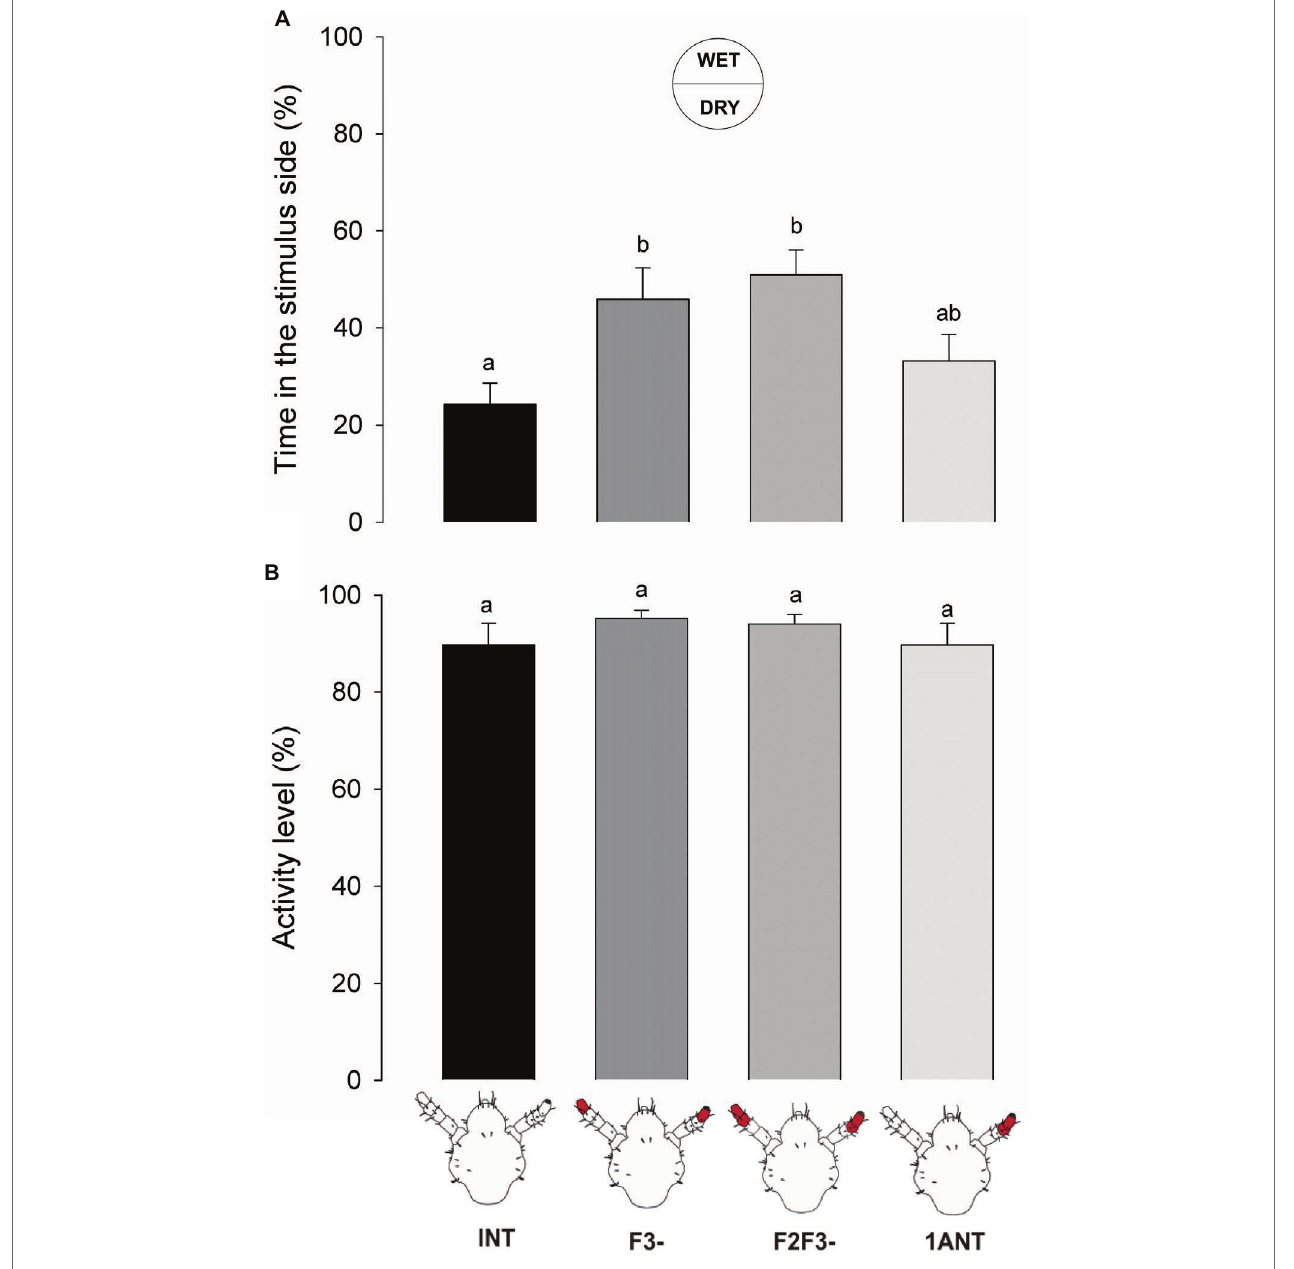
FIGURE 4 | Behavioral responses of intact and antennectomized head lice to a humid substrate. (A) Hygric preference of intact and antennectomized lice in a two-choice arena, measured as the percentage of the time spent at the wet side. INT lice spent less time at the humid side of the arena than the symmetrically antennectomized ones ( F3- and F2F3- ). Lice with 1ANT displayed intermediate hygric avoidance. (B) Activity levels of intact and antennectomized head lice, measured as the percentage of the experimental time they remained active over the arena. All groups displayed similar activity levels. Each column represents the mean of 15 insects. Different letters indicate significant differences (one-way ANOVA, p <